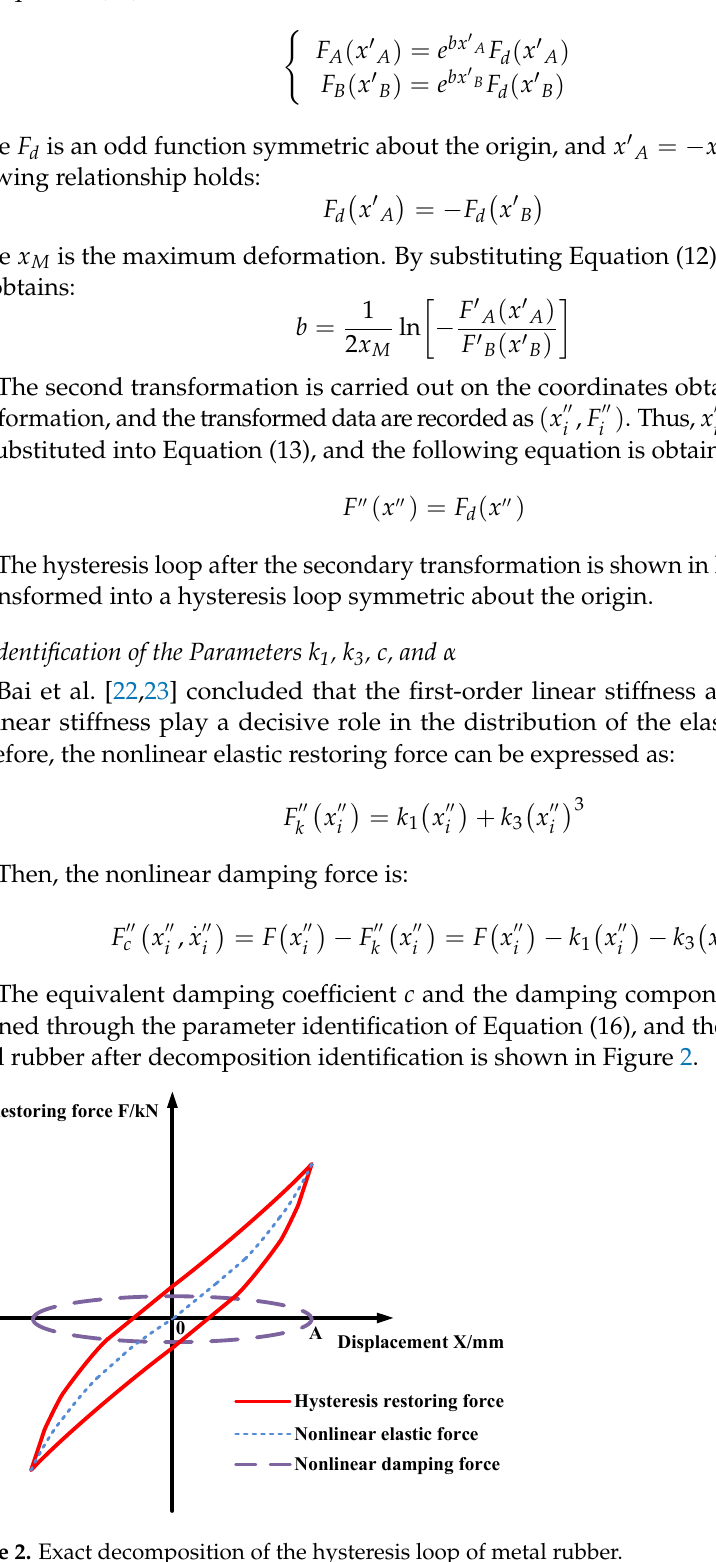
Figure 2. Exact decomposition of the hysteresis loop of metal rubber.